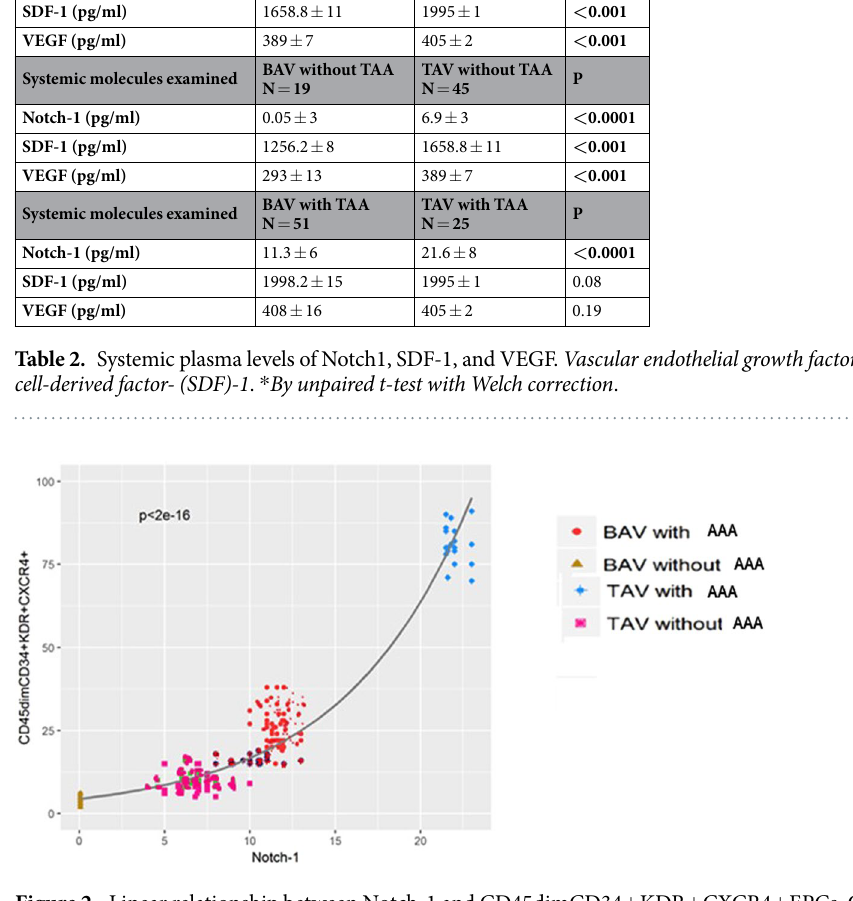
Figure 2. Linear relationship between Notch-1 and CD45dimCD34 + KDR + CXCR4 + EPCs. Generalized linear model with Poisson distribution and logarithm link correlating circulating Notch1 soluble levels with EPC subpopulation. Statistical significance tested among all groups (P < 2 E-16